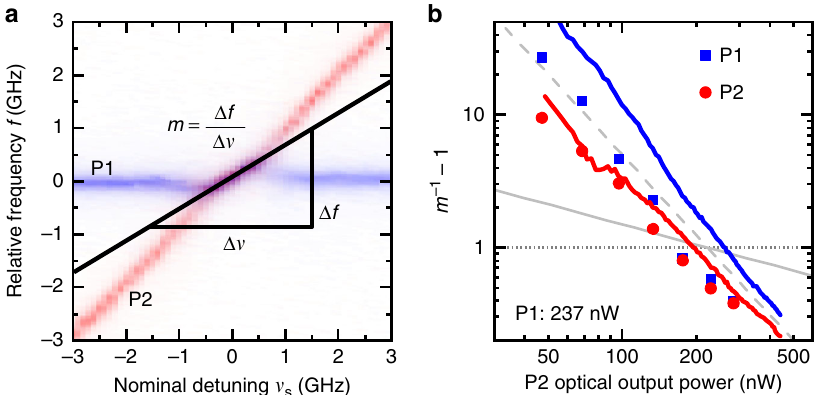
Fig. 4 Locking slopes of the two mutually coupled micropillar lasers. Panel a illustrates how the slope m is calculated. b Experimental (symbols) and numerically simulated (lines) locking slopes in dependence of the optical output power of pillar P2. The horizontal dotted line depicts the classically expected slope m = 0.5 and the oblique dashed and continuous gray lines respectively correspond to the slopes of A = − 2 and A = − 0.5 (Please see the main text for the de fi nition of